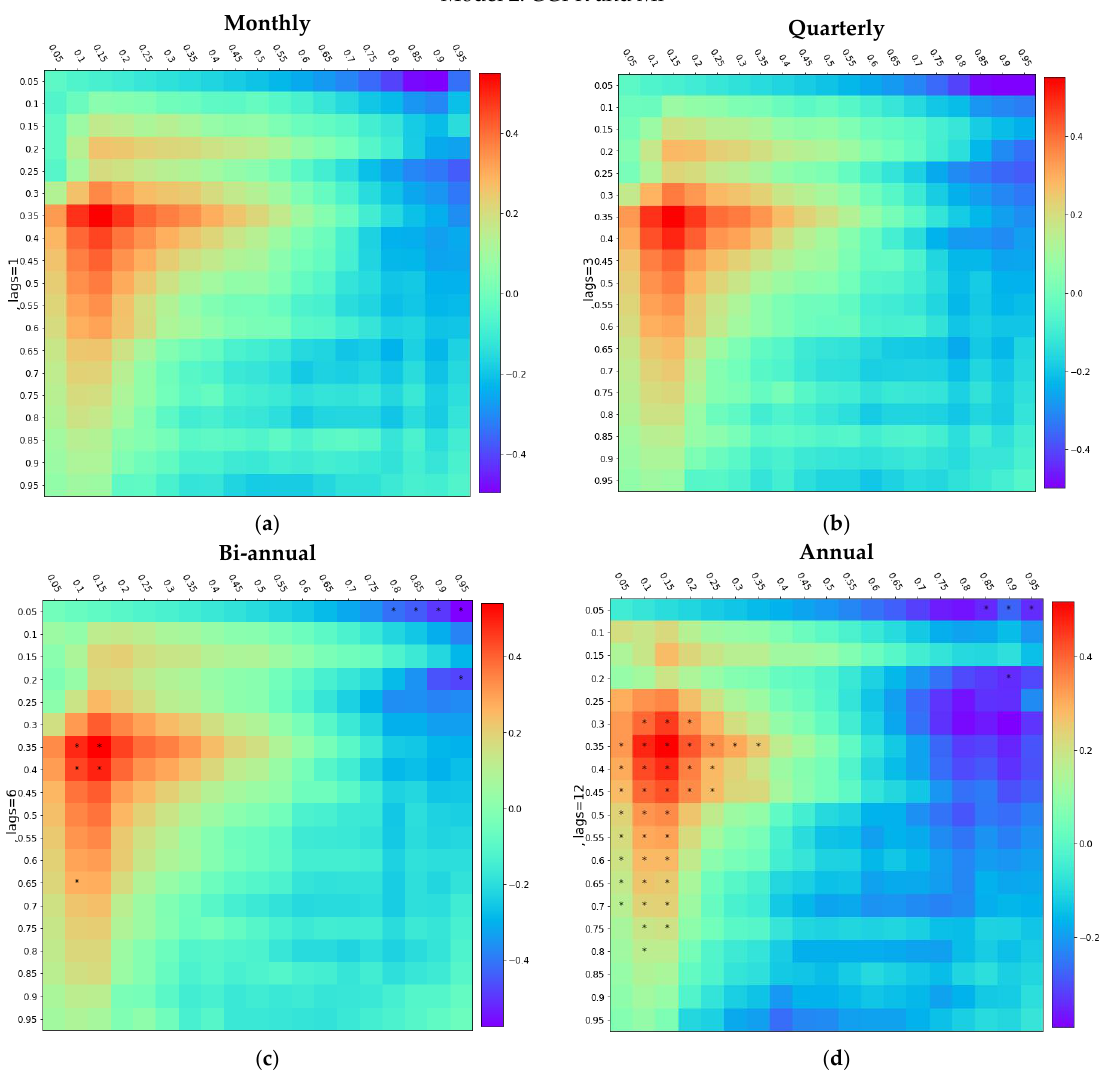
Figure 3. Effect of global geopolitical risks ( GGPR ) on mineral import ( MI ) in short (monthly ( a ) and quarterly ( b )), medium (bi-annual) ( c ) and long (annual) ( d ) memories. Notes: * shows the significance level. 0.95 depicts the highest bullish scenario, and 0.05 shows the lowest bearish state for both the GGPR and MI demand. The deep blue spectrum exhibits a solid negative consequence, while the deep red range portrays the strong positive influence of the UGPR on MI . Besides, light green and red colours display a moderately positive relationship between GGPR and MI .